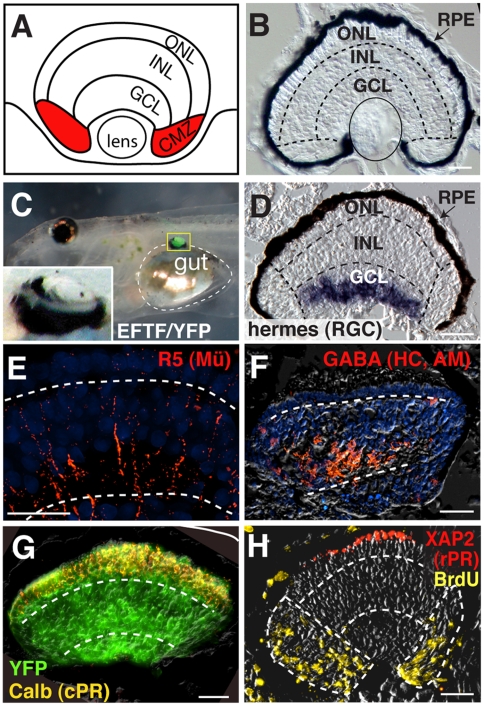
EFTF-expressing pluripotent cells form eye-like structures in tadpole flank.(A) Schematic illustrating the expected retinal layers of the eye including the outer nuclear (ONL), inner nuclear (INL), and ganglion cell (GCL) layers. The mitotically active CMZ is indicated in red. (B) Transverse section of a stage 41 wild-type retina. Dashed lines mark the location of the plexiform layers. The eye is oriented so that dorsal is to the left. (C–G) Flank eyes expressed YFP throughout, contained an RPE and a trilayered morphology with putative inner and outer plexiform layers (dashed lines in D–H). Markers were used to detect retinal cell classes. (C) Whole tadpole bright field image overlayed with fluorescent image, showing flank eye (yellow box) on top of gut (dashed line). Inlay is a magnified view of the boxed flank eye. (D) Cryostat section (12 µm) shows cells labeled for the retinal ganglion cell (RGC) marker, hermes, by in situ hybridization. (E) R5 antibody labels Müller glia (Mü; red), which extend processes the breadth of the flank retina. (F) GABA labels horizontal and amacrine cells (HC, AM; red) of the INL. (G) Cells expressing YFP (green) co-express the cone photoreceptor (cPR) marker Calbindin (yellow). (H) Cells expressing the rod photoreceptor marker XAP2 (rPR; red); BrdU-immunoreactivity (yellow) identifies mitotically active cells in the periphery of the same flank retina. Scale bars, 25 µm.